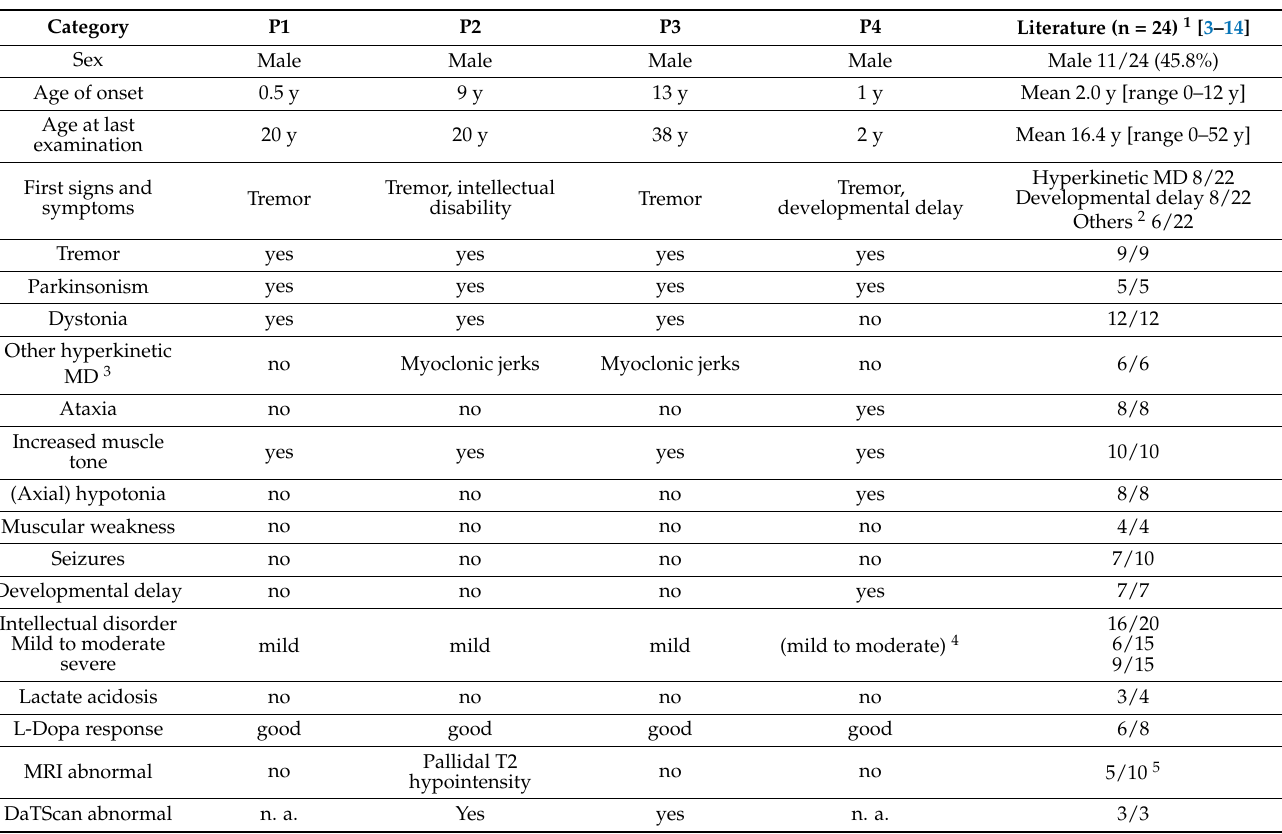
Table 1. Clinical description of the newly described patients and patients in the